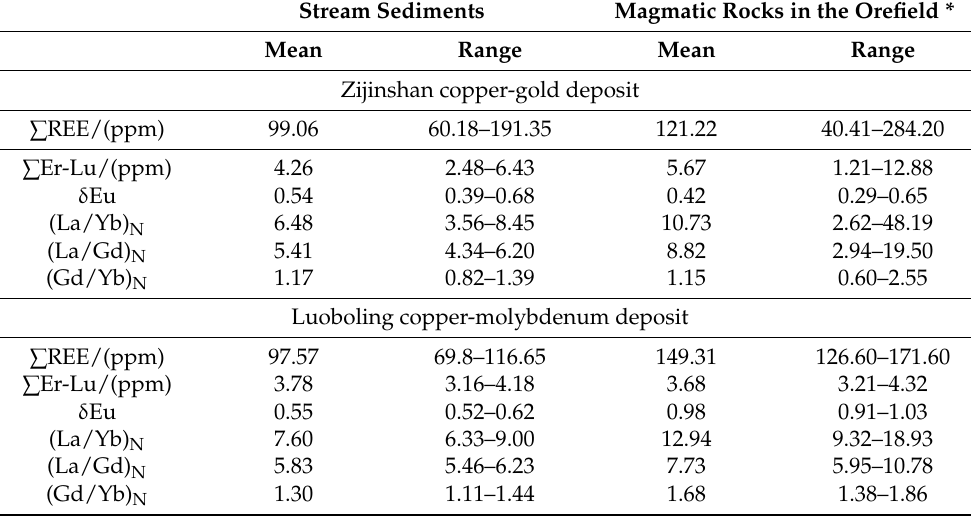
Table 2. Comparison of rare earth element compositions of stream sediments and ore-bearing magmatic rocks in the Zijinshan Copper-Gold Orefield. Stream Sediments Magmatic Rocks in the Orefield * Mean Range